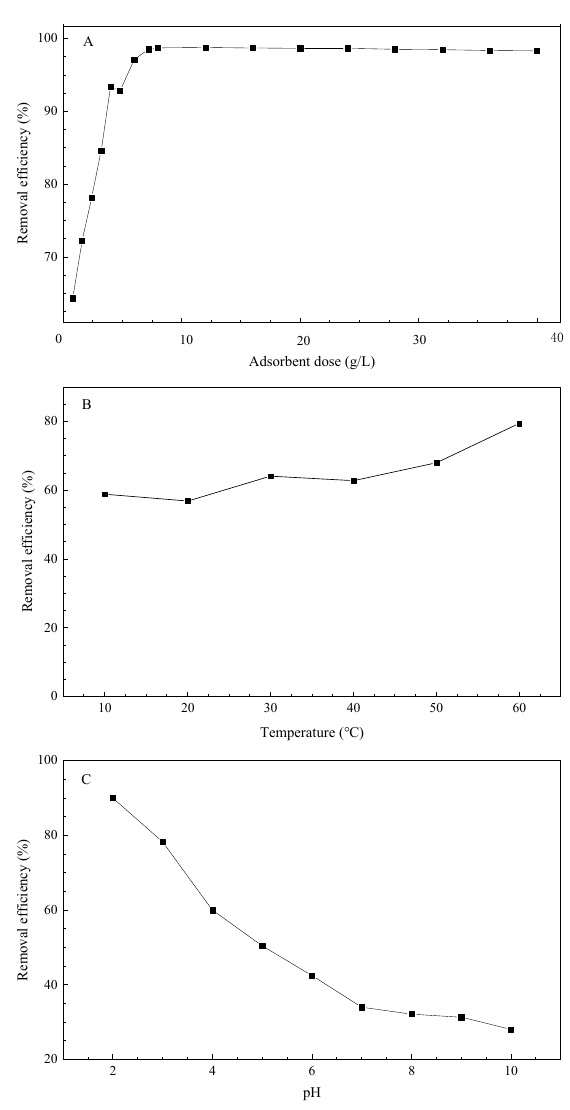
Figure 6. E ff ects of the ( A ) adsorbent dose, ( B ) temperature, and ( C ) pH on the removal of Cr(VI) by the modified peat.